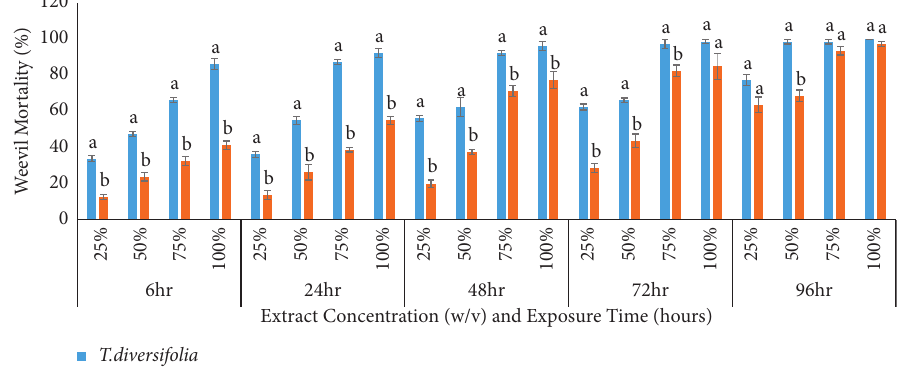
Figure 2: Comparison of the contact toxicity effects (corrected percent mortality) of ethyl acetate leaf extracts of T. diversifolia and V. lasiopus against S. zeamais . Bar graphs with different superscripts within the same concentration are significantly different at the respective test period ( p ≤ 0 . Table 9: Lethal dose (LD 50 ) of selected organic leaf extracts of T. diversifolia and V. lasopus against S. zeamais in stored maize grains. Plant